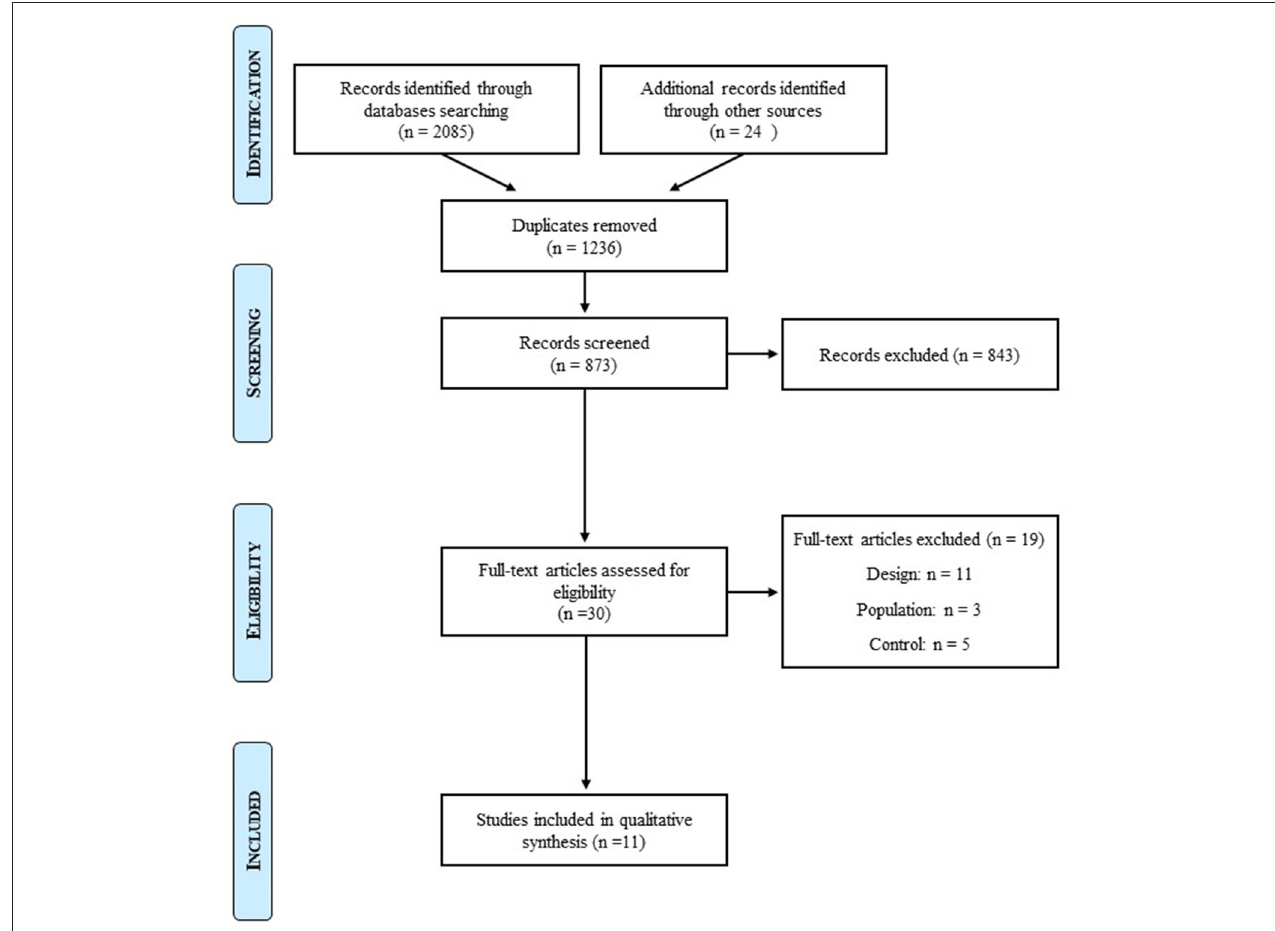
FIGURE 1 | Prisma flow